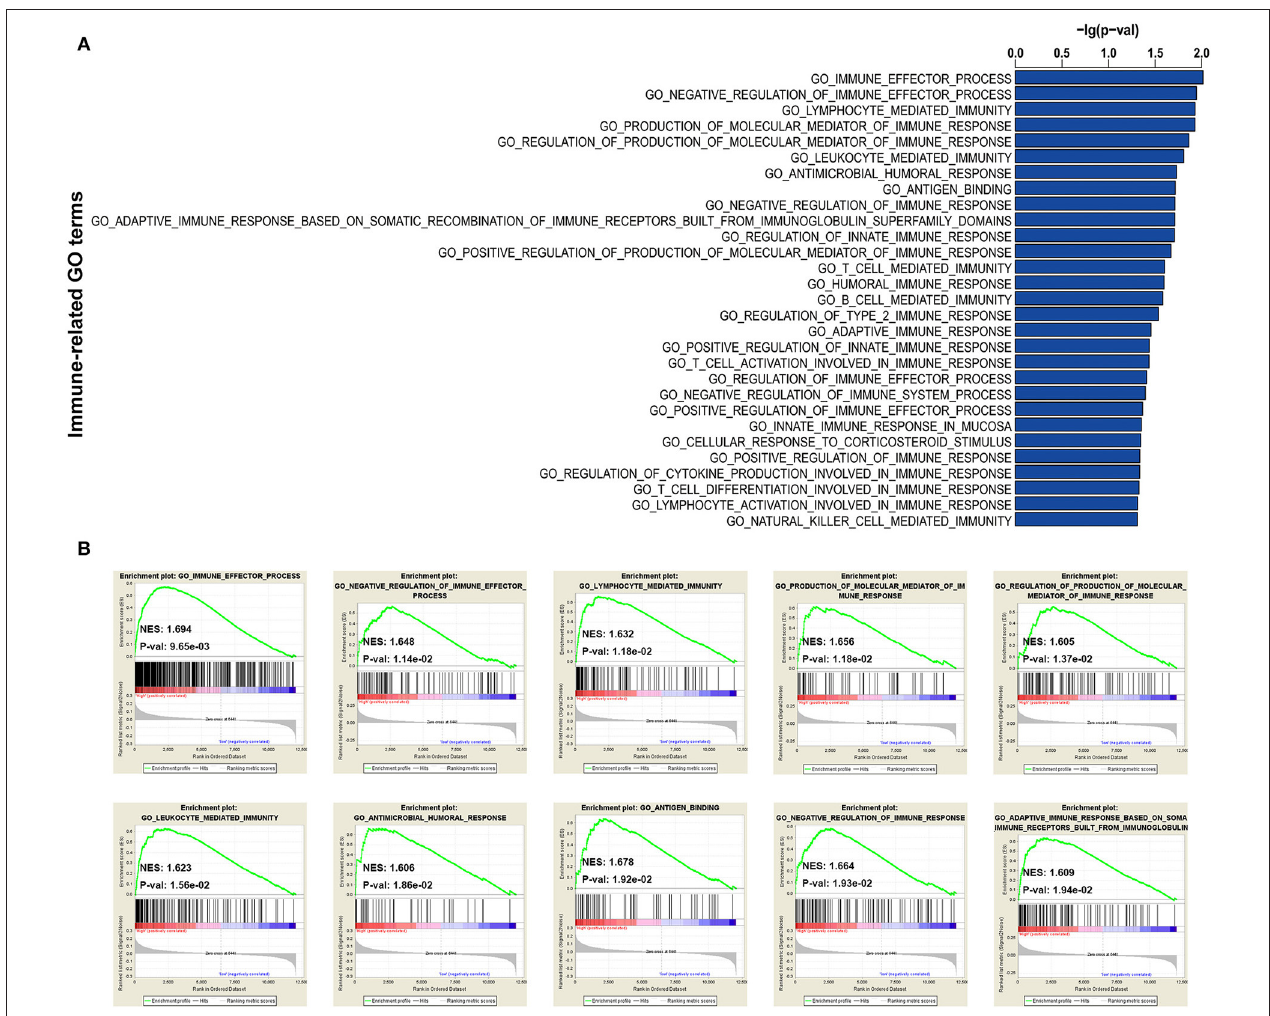
FIGURE 5 | GSEA for comparing immune-related GO terms between immune low- and high-risk groups. (A) Total of 29 immune-related GO terms significantly enriched in high-risk immune group. (B) The visualization of the top 10 enrichments in high-risk immune group. further construct an IIRPSS by LASSO Cox regression